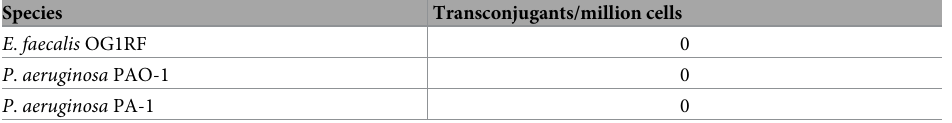
(This table can be omitted without losing information, but will be useful for a reader who only glances at the article instead of reading it